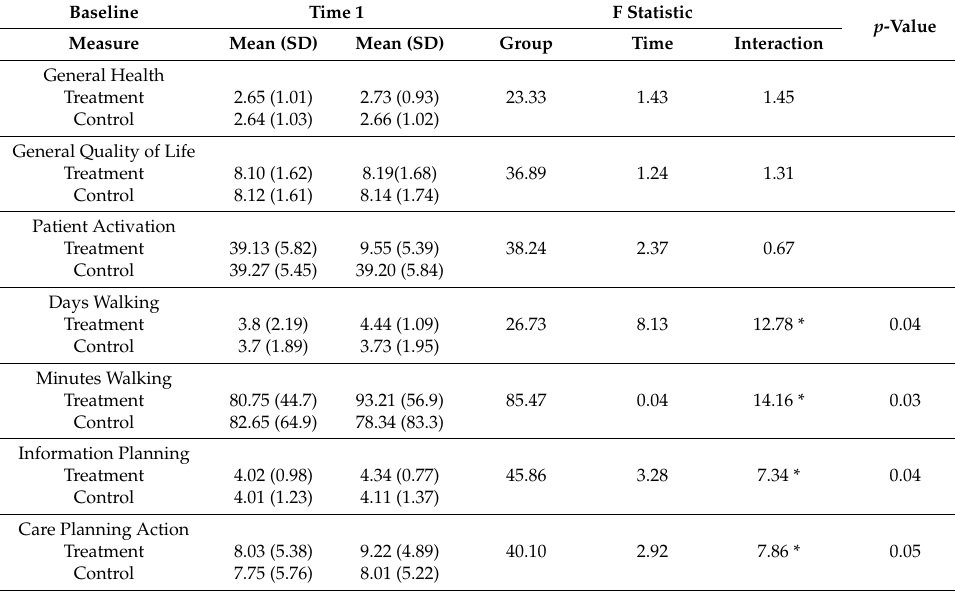
Table 2. Change in participants’ baseline to Time 1.